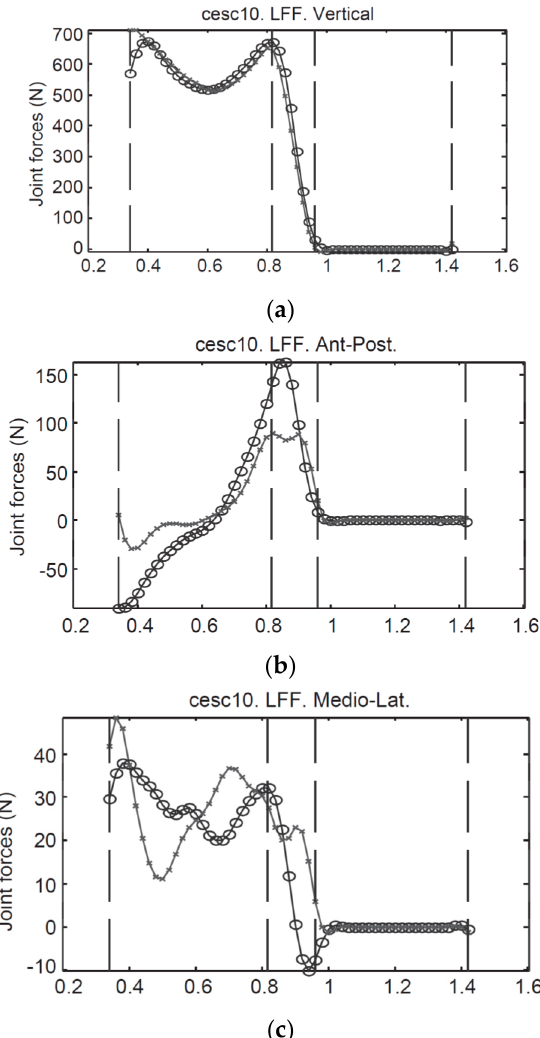
Figure 10. Comparison of the estimated (solid line X) vertical ( a ); antero-posterior ( b ) and medio-lateral ( c ) GRFs with the force-plates measurements (dotted line O) (after [63]).